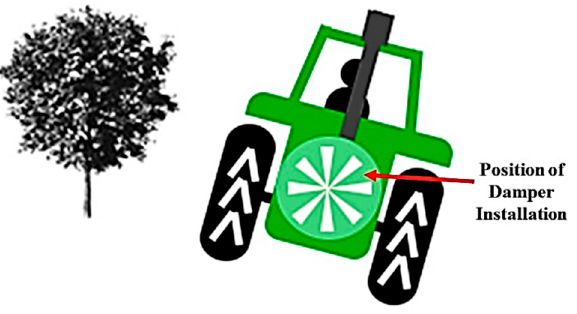
Figure 7. Position of damper installation for precision sprayer airflow control.